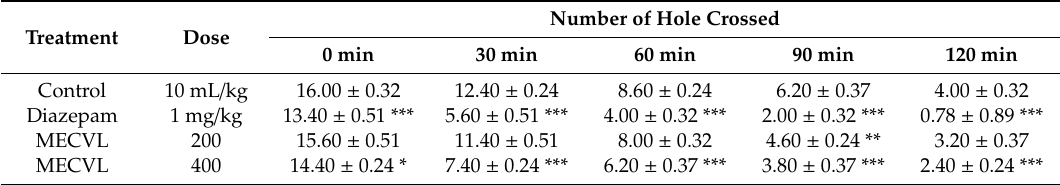
Table 2. E ff ect of MECVL in the hole cross test.